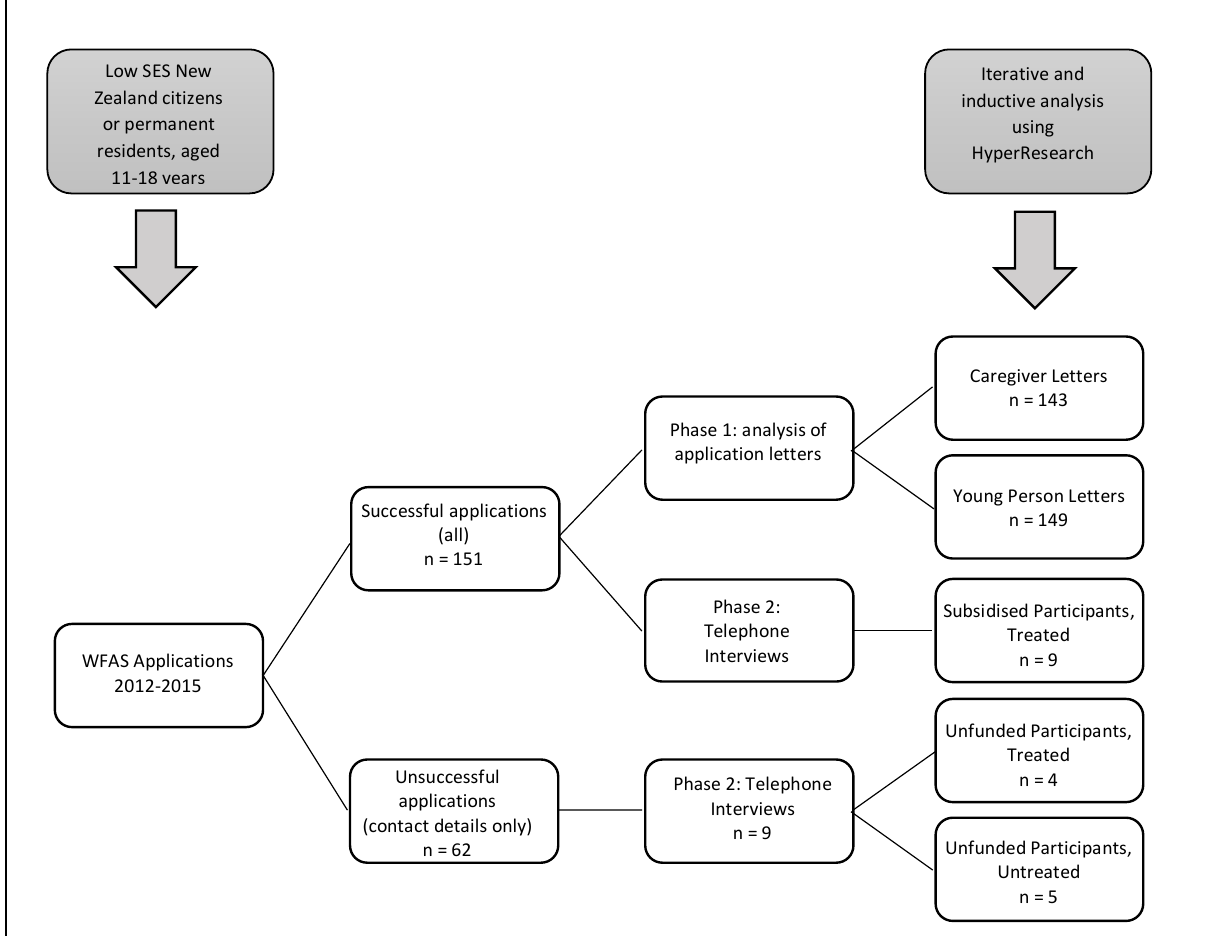
Figure 1. Data source and methods.